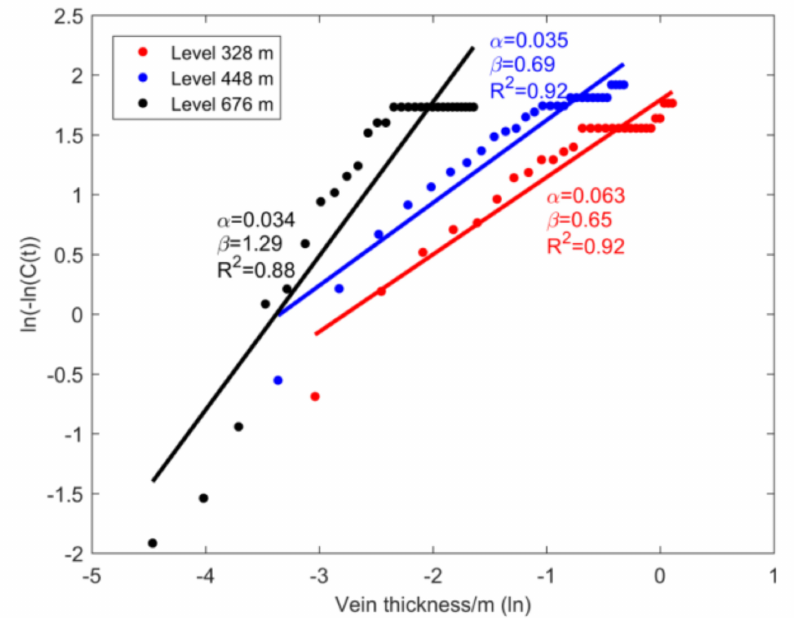
Figure 6. The fitted Weibull distribution of vein thickness at different levels. The X -axis is the logarithmically transformed vein thickness. For Y -axis, the Appendix A shows the linear relationship between ln ( − lnC ( t )) and lnt . β is the slope of the fitted